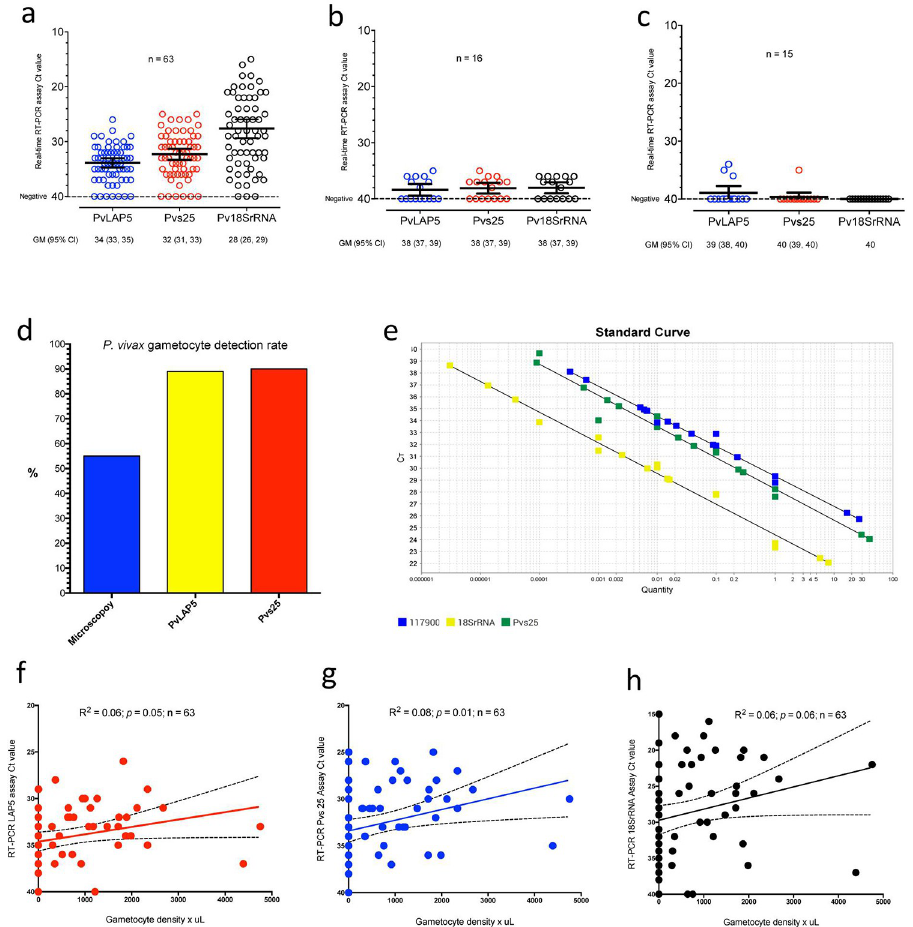
Fig 3. Molecular detection of Plasmodium vivax . a) qRT-PCR Ct values of P . vivax positive field samples for gametocyte markers PvLAP5 and Pvs25 and constitutive marker Pv18SrRNA . N = 63. b) qRT-PCR Ct values of P . vivax negative human control samples for gametocyte markers PvLAP5 and Pvs25 and constitutive marker Pv18SrRNA . N = 16. c) qRT-PCR Ct values of P . vivax malaria na ï ve lab-bred Aotus monkeys samples for gametocyte markers PvLAP5 and Pvs25 and constitutive marker Pv18SrRNA . N = 15. d) P . vivax gametocyte detection rate plot. Microscopy vs qRT-PCR PvLAP5 and Pvs25 assays. N = 63. e) qRT-PCR standard curve plots of gametocyte markers PvLAP5 and Pvs25 and constitutive marker Pv18SrRNA . f-h) Linear regression plots of gametocyte markers PvLAP5 and Pvs25 and constitutive marker Pv18SrRNA against gametocyte density x μ L. N = 63. R 2 = coefficient of determination. Dotted lines represent 95% confidence intervals. Ct values � 38 are considered positive.